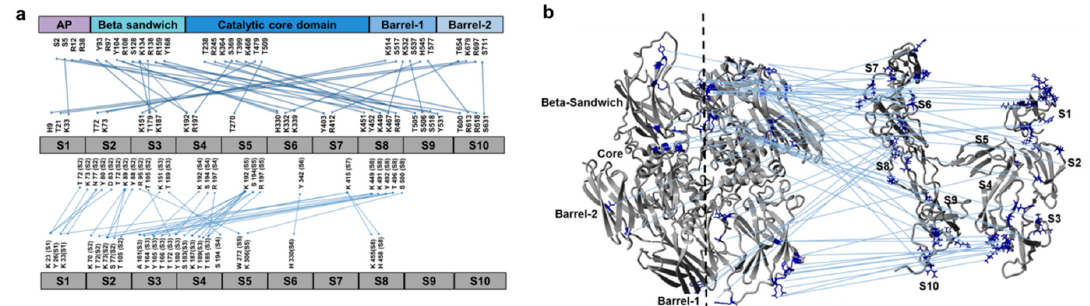
Figure 2. Cross-linking and mass spectrometry (XL-MS) derived cross-linking residues of FXIII complex reveals an N-to C-terminal symmetry. ( a ) shows the domain-wise distribution of both FXIII-B monomer model docking to FXIII-A 2 crystal structure, distance constraints (upper part of image), and monomer FXIII-B model assembly, distance constraints (lower part of image), that were generated from the XL-MS cross-linking information of the purified FXIII-A 2 B 2 heterotetramer complex (Supplementary Tables S2 and S3). ( b ) shows a structural description of the information shown in ( a ). The crystal structure of the FXIII-A subunit dimer and the monomer model of the FXIII-B subunit have been illustrated in ribbon format.